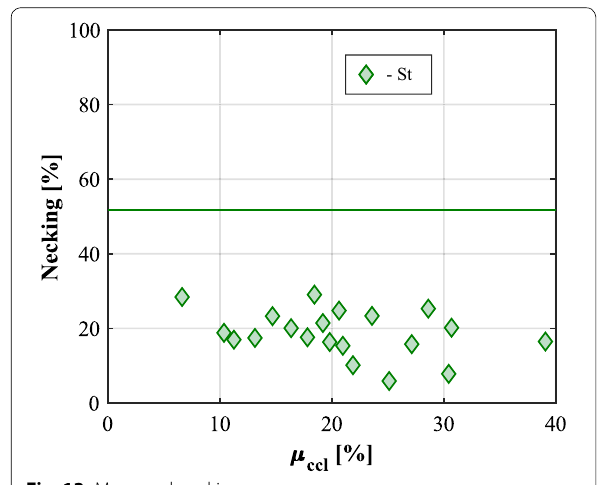
Fig. 13 Measured necking versus μ ccs